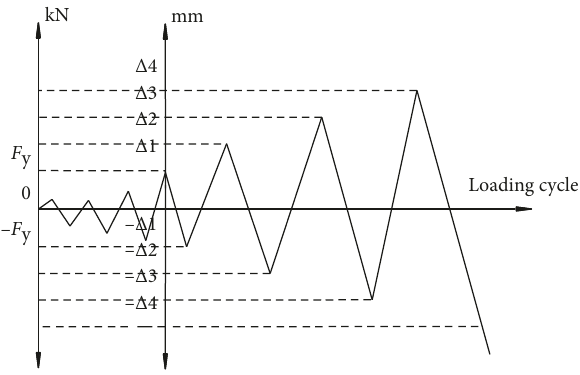
Figure 4: Load-displacement loading method.